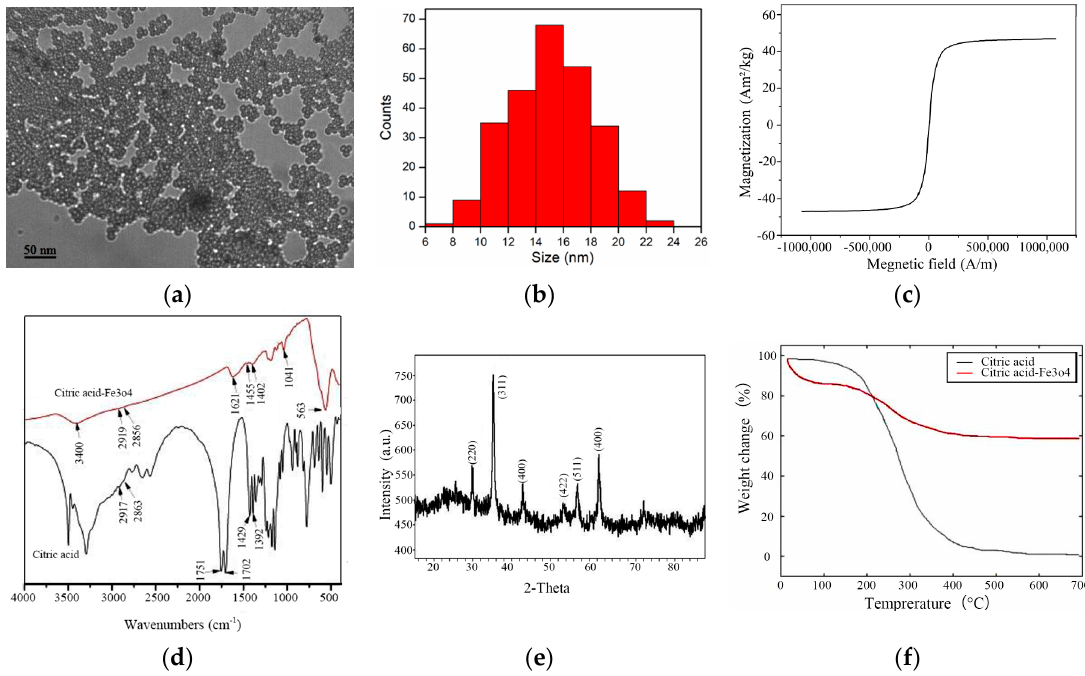
Figure 1. Characterization of prepared Fe 3 O 4 nanoparticles (NPs): ( a ) TEM micrograph of NPs; ( b ) Size distribution of NPs measured by dynamic light scattering; ( c ) Field dependence of magnetization (Magnetization vs. Magnetic field) plot of NPs at 25 °C; ( d ) Fourier transform infrared (FTIR) spectra of pure citric acid and citric acid-coated NPs; ( e ) X-ray diffraction (XRD) pattern of prepared NPs; ( f ) Thermogravimetric (TG)-DTA plots of citric acid and citric acid-coated NPs.